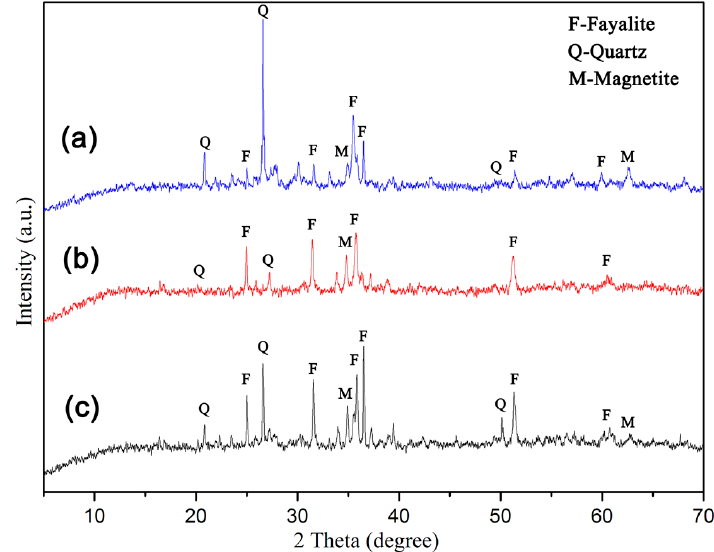
Figure 5. X-ray diffraction (XRD) patterns of: ( a ) air duct deposit (S3); ( b ) external deposit on kiln wall (S1); ( c ) internal deposit on kiln wall (S2).